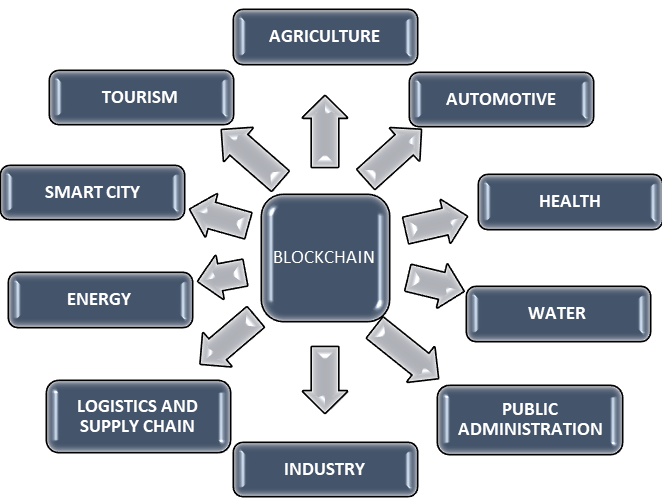
Figure 1. Blockchain implementation sectors.